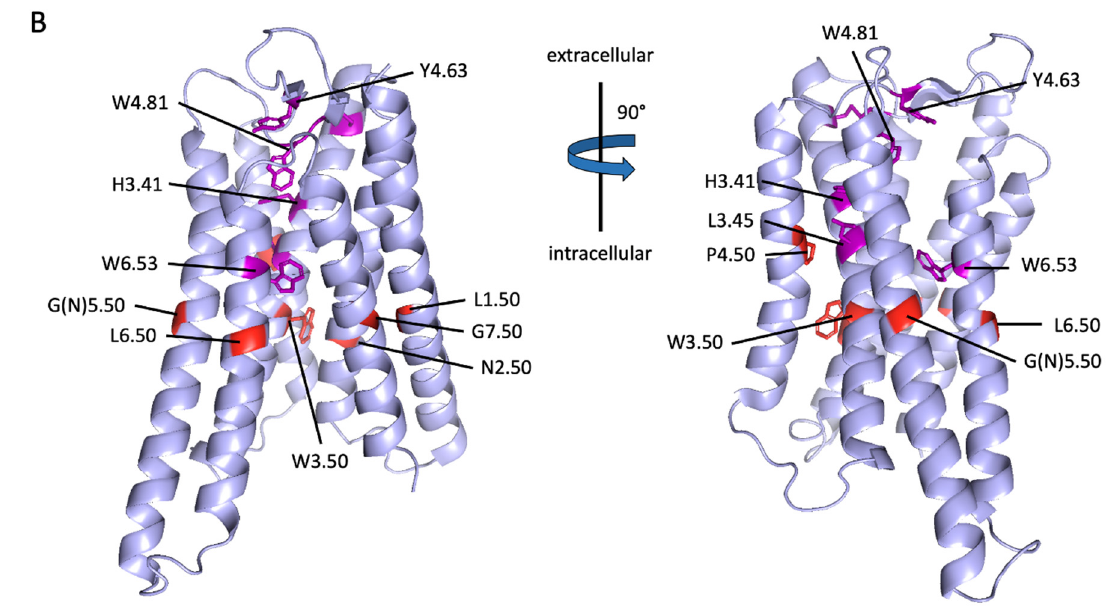
Figure 6. Projection of reference positions and conserved positions in aGPCRs on the cryo-EM structure of ADGRG3/GPR97. ( A ) The amino acid sequence alignment of the seven transmembrane helixes (TM1-7) of human aGPCRs and secretin-like receptors is shown. The previous reference positions (blue) [48] and the newly assigned reference positions (red) are given. ( B ) The newly assigned reference positions (red) and positions which are almost >90% conserved among vertebrate aGPCRs (magenta) are projected into the 7TM domain cryo-EM structure of ADGRG3/GPR97 (PDB: 7D76, [42]). W3.50 (red), P.4.50 (red) and G7.50 (red) are >99% conserved reference positions in vertebrate aGPCRs. The 7TM domain structure is given in two views rotated by 90°.